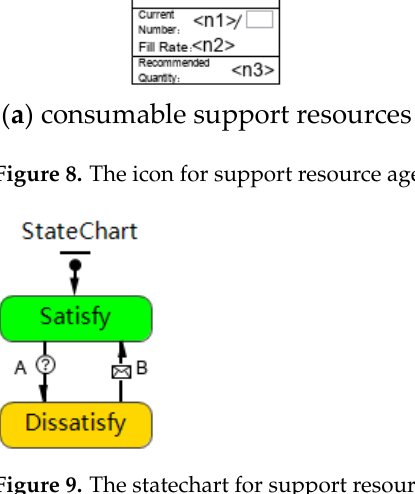
Figure 10. Communication logic between equipment agent and support resource agent. As shown in Figure 10, the equipment agents send a list of required support resources to all support resource agents in the event of a fault, and the support resource agents